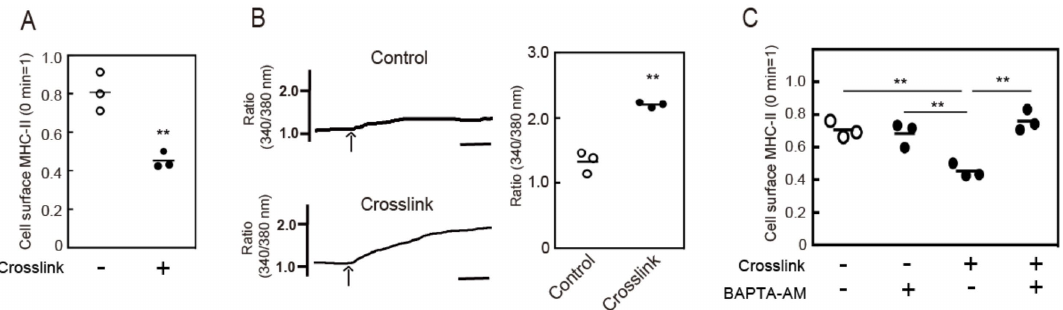
Figure 1. Intracellular Ca 2+ mobilization is required for crosslinking-induced endocytosis of major histocompatibility complex class II (MHC-II). ( A ) Bone marrow-derived dendritic cells (BMDCs) were incubated with an anti-MHC-II antibody for 30 min at 4 °C. For crosslinking, the cell surface MHC-II was incubated with a biotin-labeled anti-mouse IgG antibody for 30 min at 37 °C. The remaining cell surface MHC-II was detected using PE-labeled streptavidin. ( B ) BMDCs were crosslinked with an anti-MHC-II antibody and an anti-mouse IgG antibody. The cytosolic Ca 2+ mobilization after stimulation was detected using Fura-2/AM. Bars = 1 min. Relative changes in the cytosolic Ca 2+ concentrations are expressed as the ratio of fluorescence intensity at 340/380 nm. ( C ) BMDCs were pretreated with vehicle (0.1% dimethyl sulfoxide (DMSO)) or BAPTA-AM (50 µM) for 30 min at 37 °C. The cell surface MHC-II was crosslinked with an anti-MHC-II antibody for 30 min. The remaining cell surface MHC-II was detected by flow cytometry. Values of ** p < 0.01 are regarded as significant.